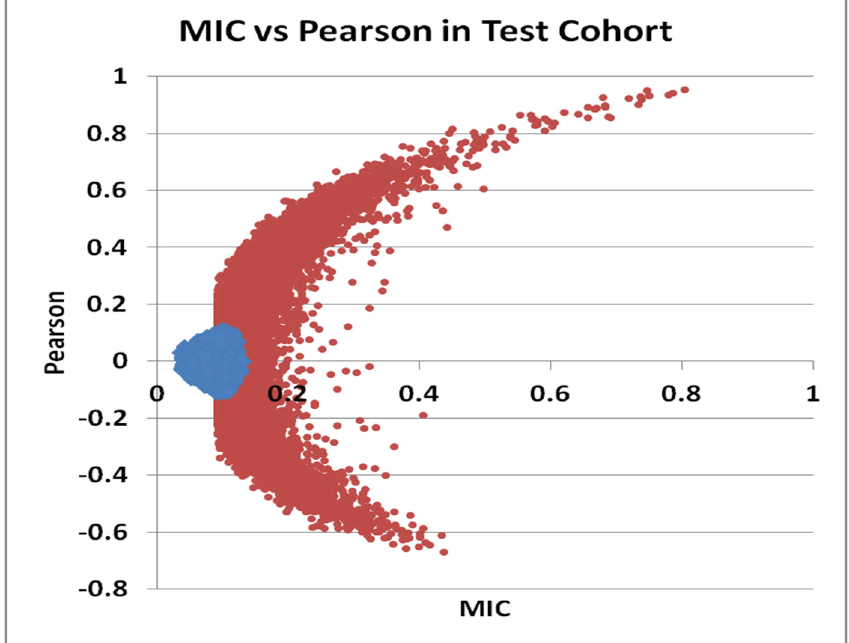
Figure 1. Scatter plot of Maximal Information Coefficient and Pearson correlation of ncRNAs in the Test cohort ( n = 3302). The values for 40,486 pairs of ncRNAs (T-UCRs and miRs) are reported in red. In blue are also plotted the values for the simulation.